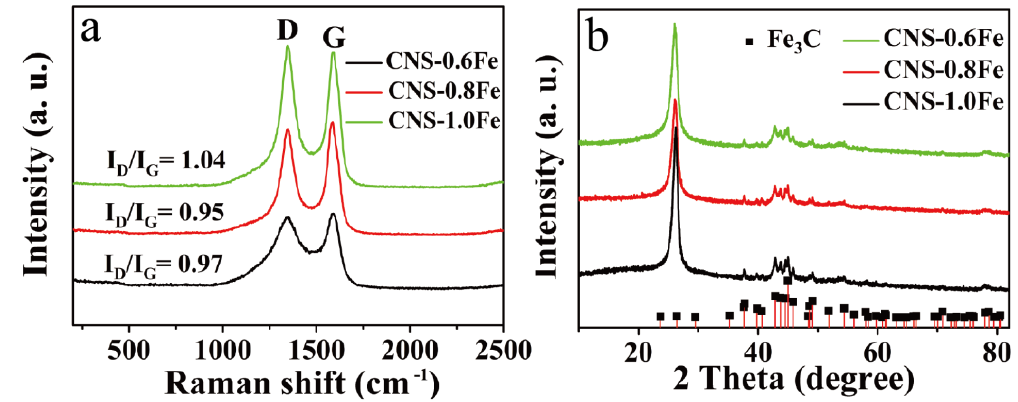
Figure 4. ( a ) Raman spectra of CNS – 0.6Fe, CNS – 0.8Fe and CNS – 1.0Fe catalysts. ( b ) XRD patterns of